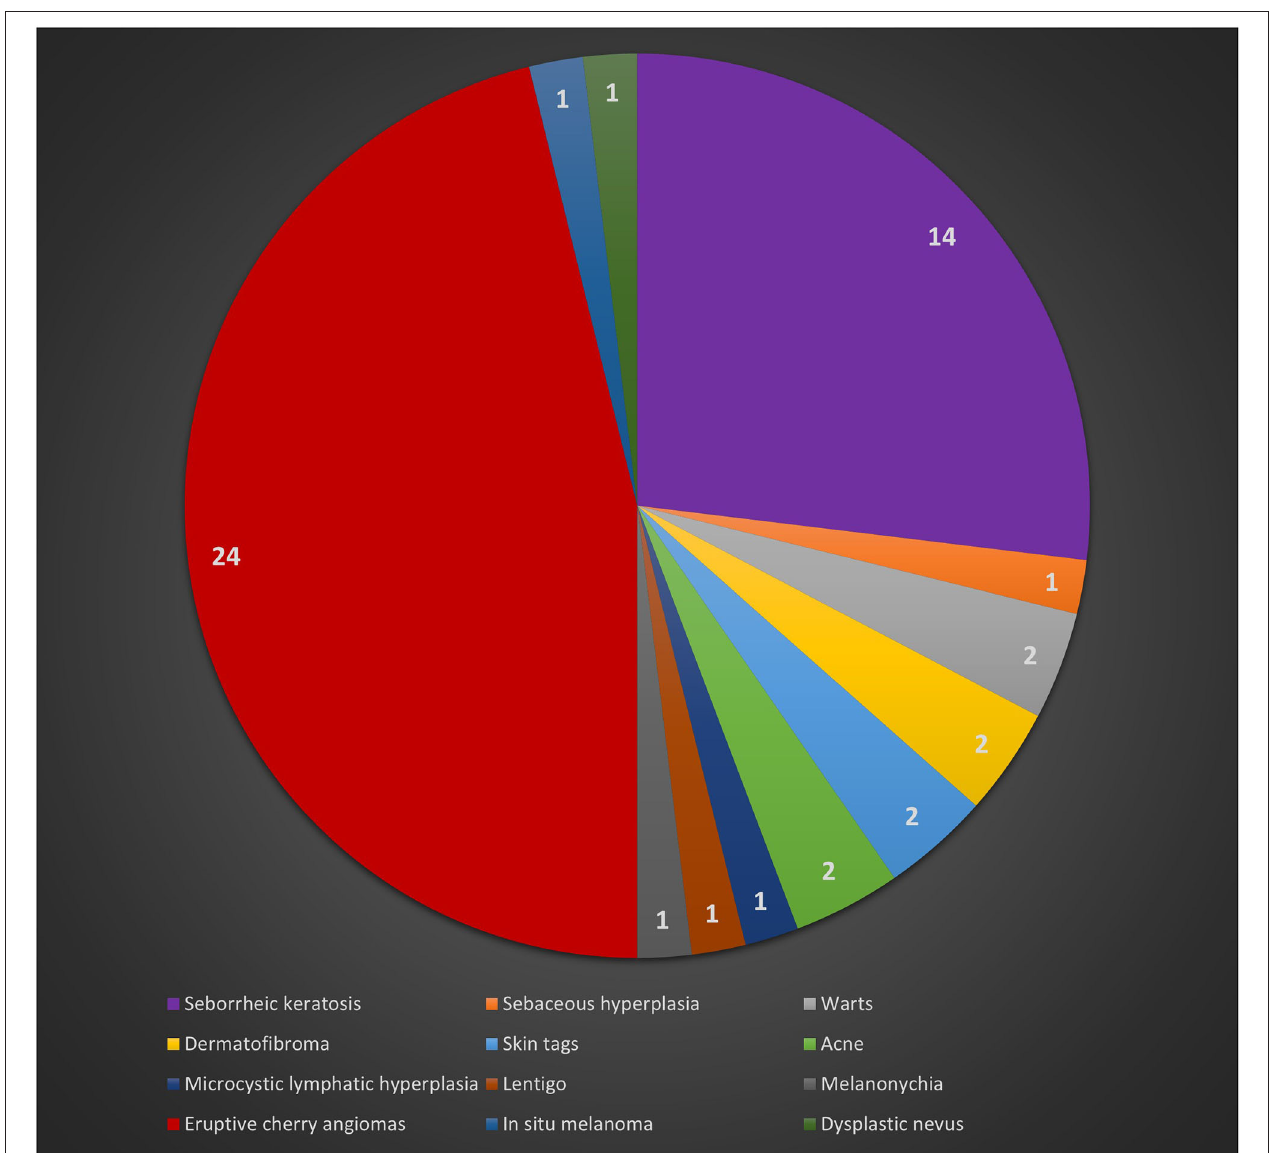
FIGURE 3 | Occurrence of cutaneous lesions identified during the